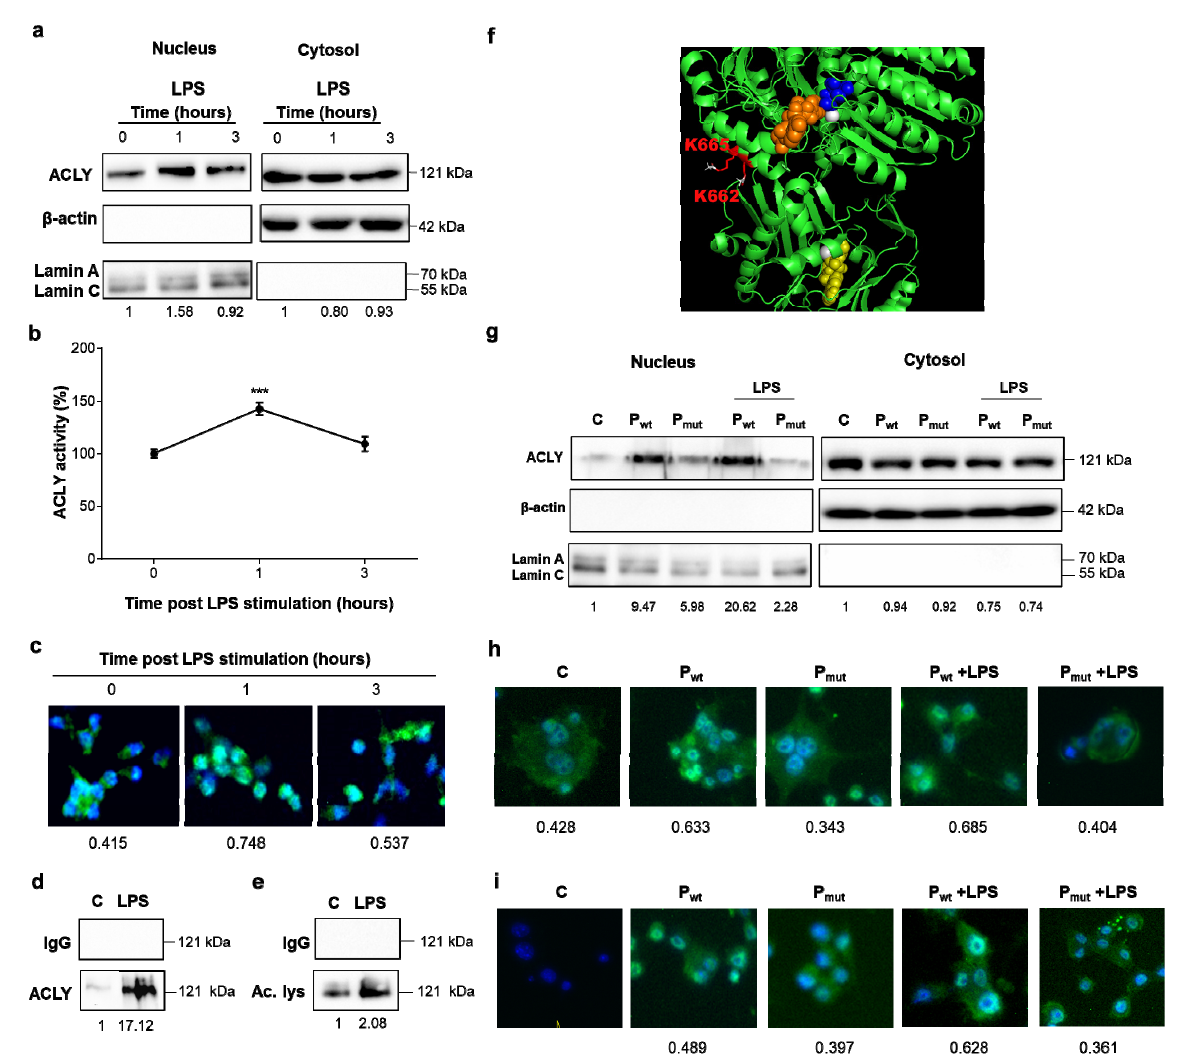
Figure 2. LPS induced ACLY acetylation and, in turn, its nuclear translocation. Human PBMC-derived macrophages were triggered by LPS, and ( a ) nuclei were isolated by cell fractionation. In nuclear and cytoplasm fractions, ACLY, β -actin, and lamin proteins were detected by specific antibodies. ( b ) Nuclear ACLY activity. ( c ) Time course of ACLY nuclear translocation by immunocytochemistry (ICC) using anti-ACLY and DAPI nuclear staining. ( d ) Immunoprecipitated with an antibody directed to acetylated lysine and analyzed by western blot with an anti-ACLY antibody. ( e ) In macrophages triggered by LPS, ACLY was immunoprecipitated with a specific antibody, and then an antibody against acetylated lysine (Ac. Lys.) was used in western blotting experiments. ( f ) A 3D model of ACLY protein based on 6hxh.pdb is reported in a green cartoon representation and in a complex with citrate (blue spheres), ADP (yellow spheres), Mg (white spheres), and CoA (orange spheres). K662 and K665 acetylated lysines are reported in red sticks. (Acetyl groups added by PyMOL on K662 and K665 are reported in white sticks) ( g ) iBMDM cells were transfected with a construct overexpressing the ACLY wild type (Pwt) and a construct overexpressing a double Ala mutant (Pmut) and used for isolating nuclei. In nuclear and cytoplasm fractions, ACLY, β -actin, and lamin proteins were detected by specific antibodies. ( h ) iBMDM cells, transfected as in ( g ), were used for ICC analysis with anti-ACLY and DAPI nuclear staining. ( i ) iBMDM cells, transfected as in ( g ), were used for ICC analysis with an anti-DDDDK tag and DAPI nuclear staining. In ( a , b ), IgG is the negative control. In ( b ), data are representative of 3 independent experiments and are presented as means ± SD (error bars). Statistical significance of the differences was evaluated by using one-way ANOVA followed by Dunnett’s multiple comparison test (*** p < 0.001). Western blotting and ICC data presented are representative of at least 3 independent experiments. In ( a , g ), protein levels are quantified against β -actin or lamin. In ( a , d , e , g ), they are normalized versus the mean of proteins in untreated cells (C) and reported under each image. Quantitation of ACLY in ( c , h , i ) ICC images was normalized to a DAPI nuclear stain.